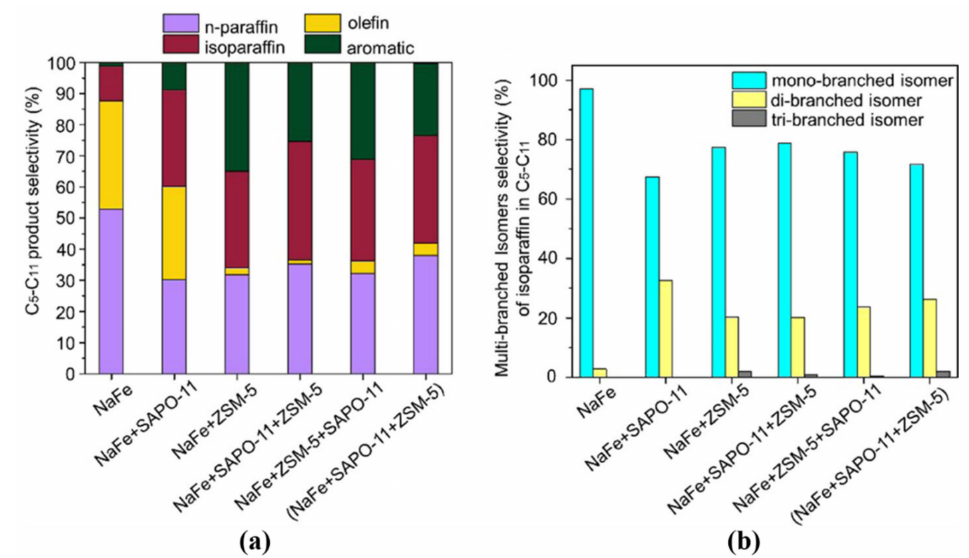
Figure 8. CO 2 hydrogenation over NaFe coupled with HZSM-5 and SAPO-11 for gasoline (C 5 –C 11 ) synthesis: ( a ) hydrocarbon distribution and ( b ) branched isomer selectivity in iso-paraffins. Note: “(A + B + C)” means a physical mix of A, B, and C catalysts, ”A + B” denotes the sequential addition of A and B catalysts (dual bed), and “A + B + C” symbolizes sequential addition of A, B, and C catalysts (triple bed). Reaction conditions: 320 ◦ C, 3.0 MPa, W NaFe /F = 6 g cat · h/mol, H 2 /CO 2 = 3. Reprinted with permission from Noreen et al. [70]. Copyright (2020) American Chemical